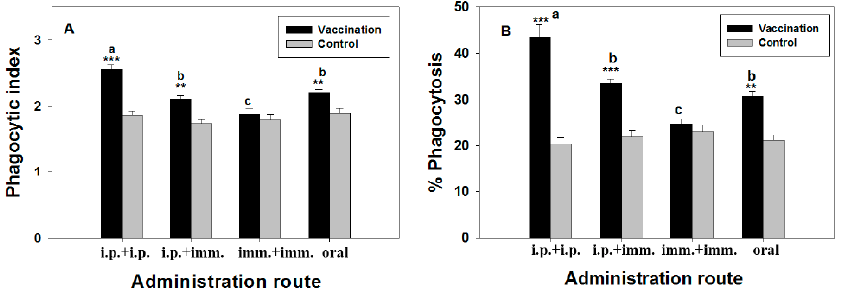
Figure 6. Phagocytic activities (( A ) phagocytic index, ( B ) percent phagocytosis) of pronephric macrophages of silver sea bream ( N = 7) immunized with formalin-killed bacterins via different administration routes. Significant differences from control were expressed as ** p < 0.01 and *** p < 0.001. Significant differences among groups of immunized fish were shown as a, b, and c (a > b > c).